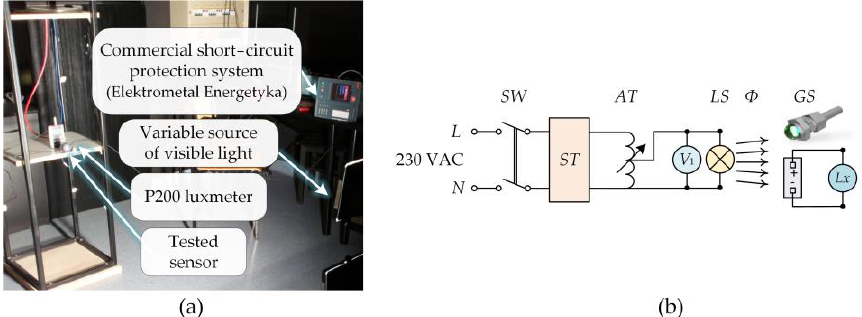
Figure 6. Laboratory test bench ( a ) and the electrical diagram of the measuring system ( b ) for analysis of the activation threshold of the developed heads. The electrical circuit ( b ) contained: ST — voltage stabilizer, AT — autotransformer, LS — light source, V 1 — digital voltmeter, Φ — luminous flux, Lx – lux meter.